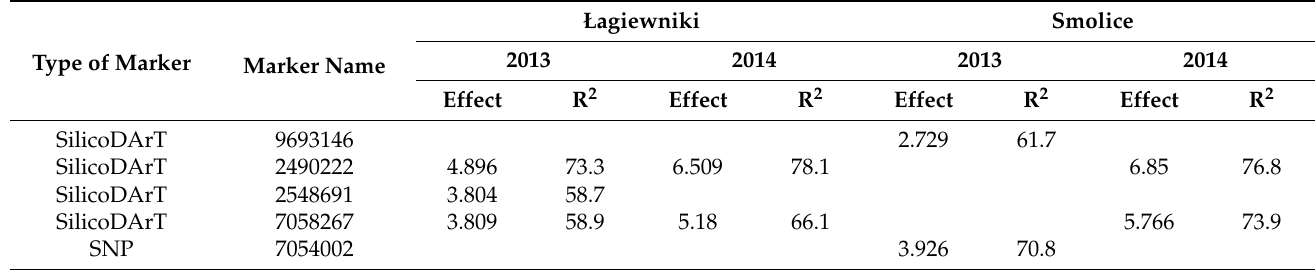
Table 9. Molecular markers associated with the heterosis effect of